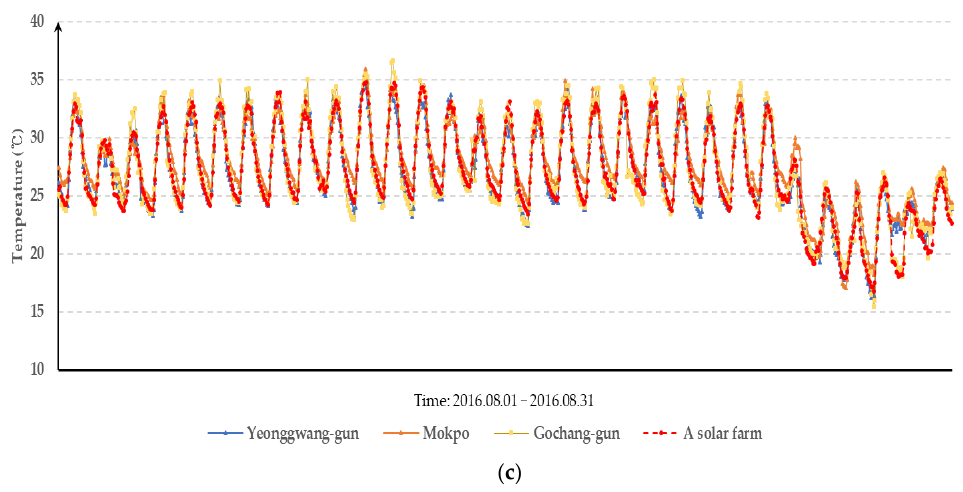
Figure 6. Weather data estimated at solar farm “A” and measured at three highly weighted neighboring points for August 2016. ( a ) Irradiance; ( b ) Humidity; ( c ) Temperature.